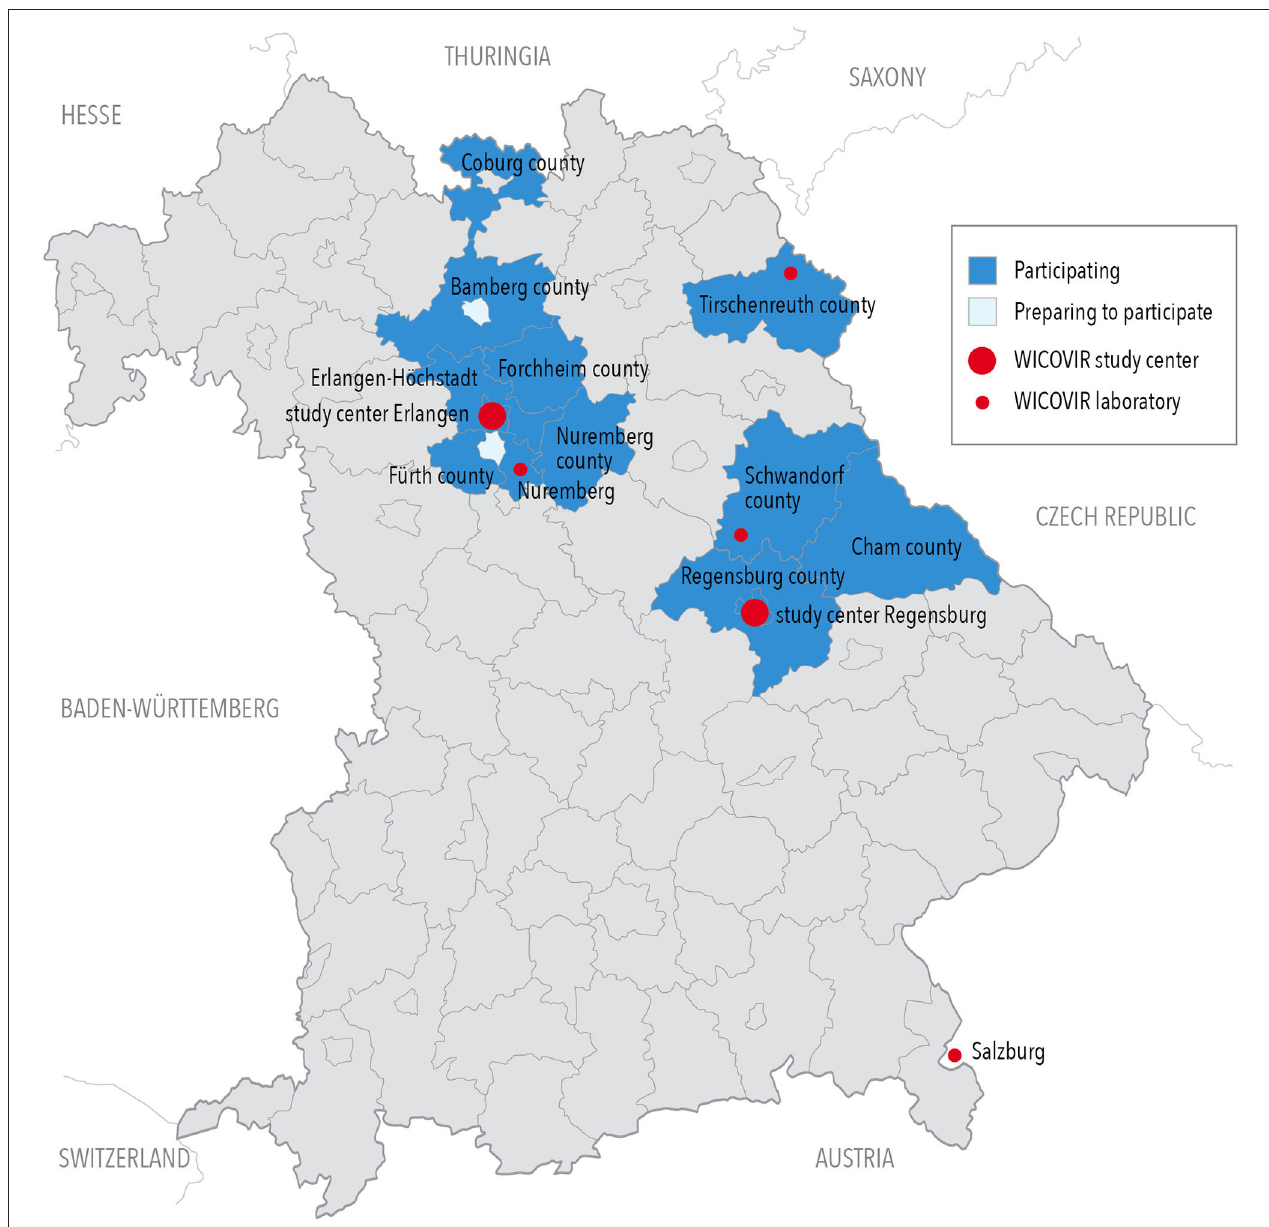
FIGURE 1 | Map of Bavarian counties participating in WICOVIR as of May 15,